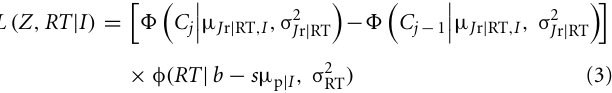
FIGURE 2 | Continuous identification (CID) task performance in Ward et al. (2013), Experiment 1. Left panel: priming effects [no significant main effect of age group, F ( 1 , 38 ) = 1 . 78, p = 0 . 19, or delay, F ( 1 , 38 ) = 0 . 02, p = 0 . 89, and no significant interaction, F ( 1 , 38 ) = 0 . 04, p = 0 . 85]. The proportional priming effect was calculated as the difference in the median identification RT to new and old items divided by the median identification RT for new items. Bars indicate the mean of the median priming across participants (error bars indicate SE of the mean), and symbols indicate the